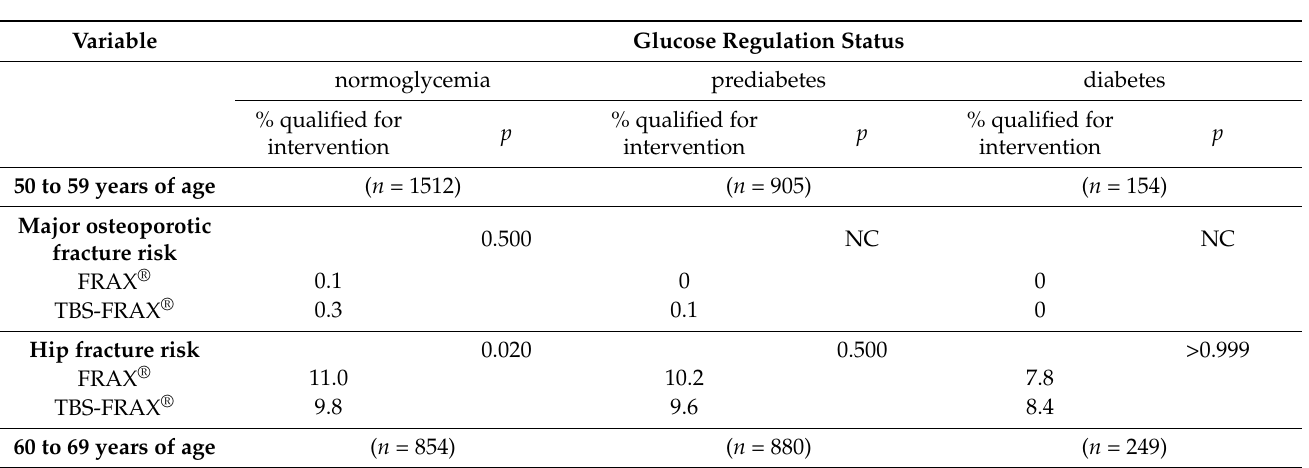
Table 4. The proportions of women in different age groups at high risk of major osteoporotic fracture ( ≥ 20%) and hip fracture ( ≥ 3%) according to the FRAX ® and TBS-FRAX ® , with stratification by glucose regulation